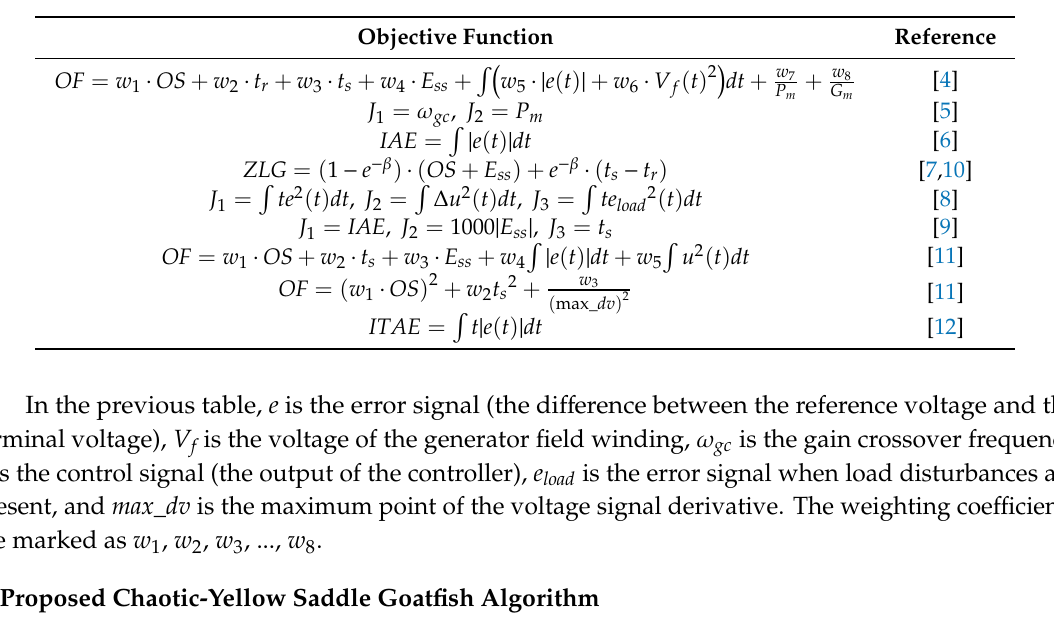
Table 4. The list of the used objective